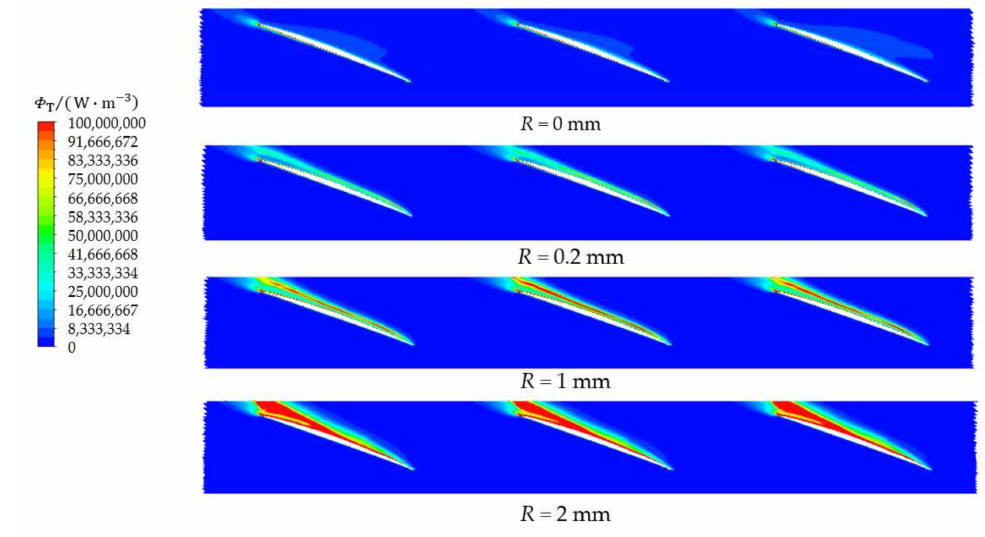
Figure 21. Cylinder distribution of internal dissipation rate of impeller under turbine condition ( r ∗ = 0.97).